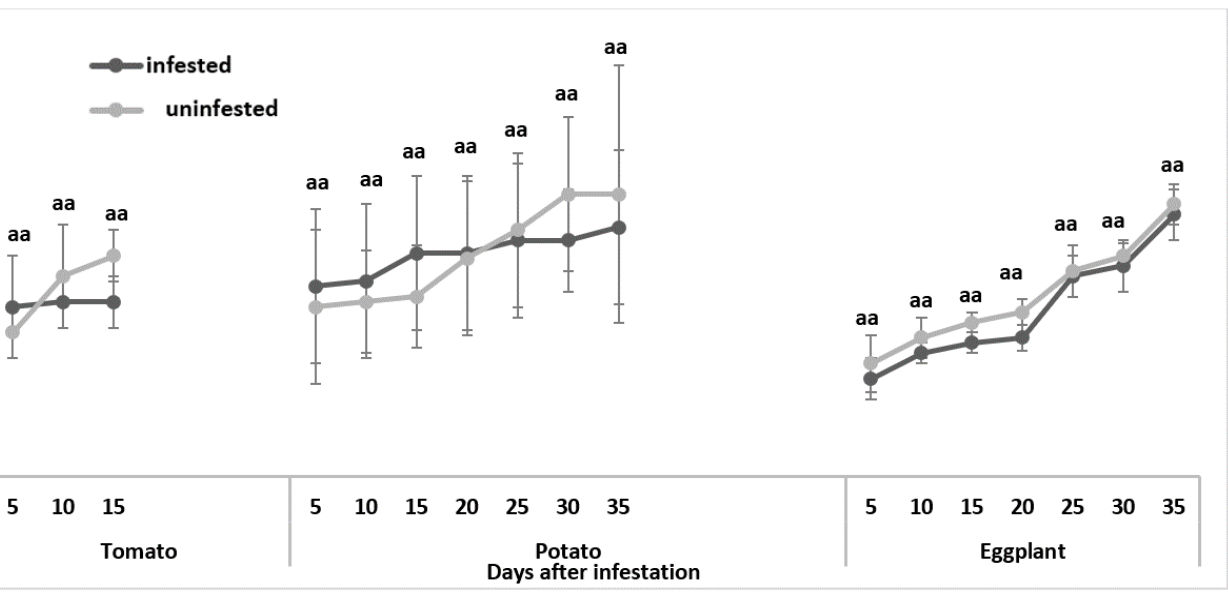
Figure 6. Comparison of mean stem diameter between uninfested and Tuta absoluta -infested plants. Means followed by different letters in the same bar column are significantly different at p < 0.05.